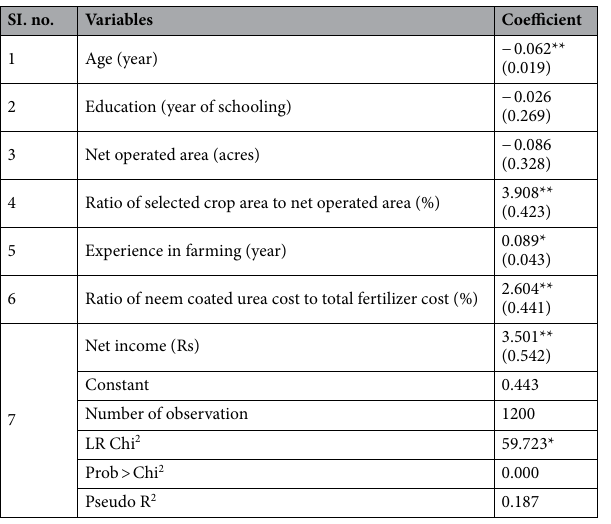
Table 10. Results of logistic regression model for neem coated urea farmers at all India. Source: Authors’ estimates using field survey data. ** & *Denotes significance level at 1 and 5%, respectively. Figures in parentheses indicate standard